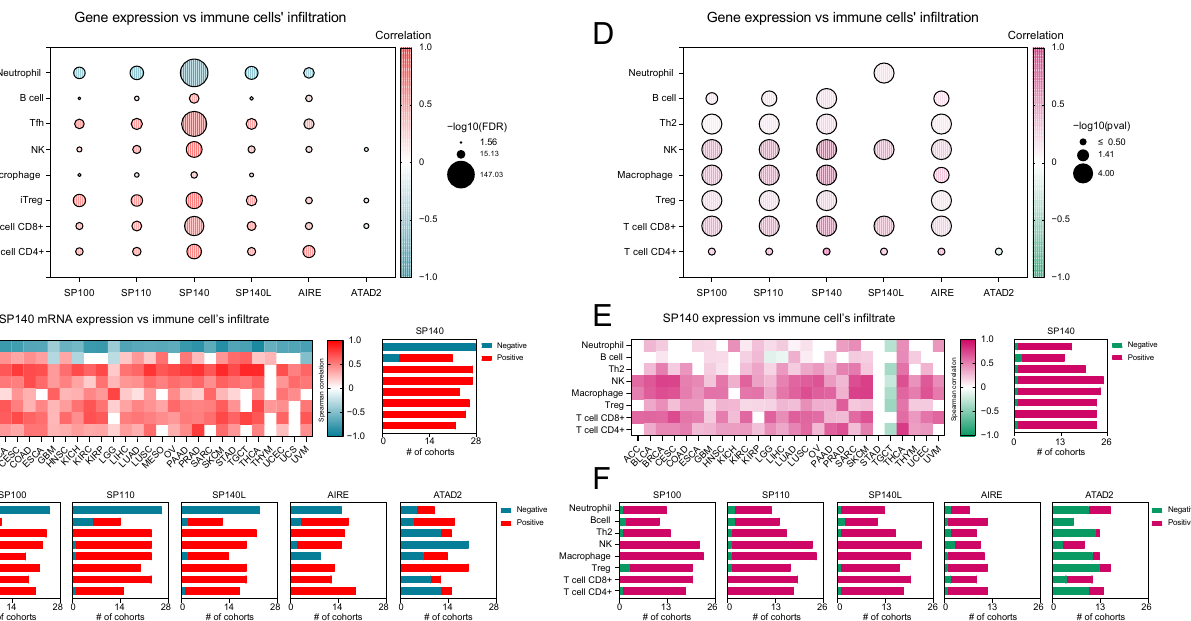
Figure 2. BrDs that belong to the SP subfamily are positively associated with tumor infiltration status. ( A ) The correlation between selected BrD family members’ expression and immune cells’ infiltration in SKCM, using the GSCA database (http://bioinfo.life.hust.edu.cn/GSCA/, accessed on 15 January 2022). Red and blue denote positive and negative correlations, respectively. Bubble size depicts statistical significance ( − log10(FDR)). ( B ) The heatmap of all statistically significant correlations between SP140 expression and immune cells’ infiltration across 28 TCGA solid tumor types, using the GSCA database. Red and blue denote positive and negative correlations, respectively. The number of TCGA cohorts correlated positively (red) or negatively (blue) is presented on the right panel. ( C ) The number of TCGA cohorts showing positive (red) or negative (blue) correlations between the expression of selected markers and immune cell infiltration using the GSCA database. ( D ) The correlation between selected BrD family members’ expression and immune cells’ infiltration in SKCM, using the TIP database (http://biocc.hrbmu.edu.cn/TIP/pancancerAnalysis.jsp, accessed on 1 March 2022). Pink and green denote positive and negative correlations, respectively. Bubble size depicts statistical significance ( − log10(pval)). ( E ) The heatmap of all statistically significant correlations between SP140 expression and immune cells’ infiltration across 26 TCGA solid tumor types, using the TIP database. Pink and green denote positive and negative correlations, respectively. The number of TCGA cohorts correlated positively (pink) or negatively (green) is presented on the right panel. ( F ) The number of TCGA cohorts showing positive (pink) or negative (green) correlations between the expression of selected markers and immune cell infiltration, using the TIP